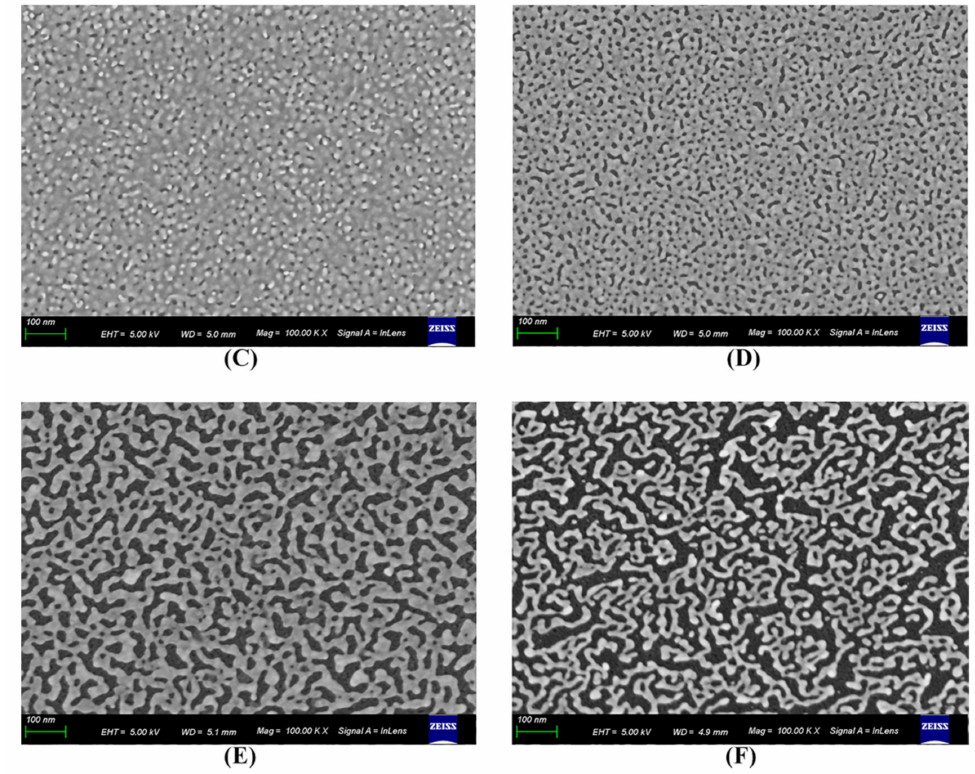
Figure 3. Surface SEM images of: ( A ) SiO 2 vertical microcavity wafer. ( B ) Au thin film deposited SiO 2 vertical microcavity biosensor die; ( C ) 10%, ( D ) 20%, ( E ) 40%, and ( F ) 60% porosity NPG deposited SiO 2 vertical microcavity biosensor die.